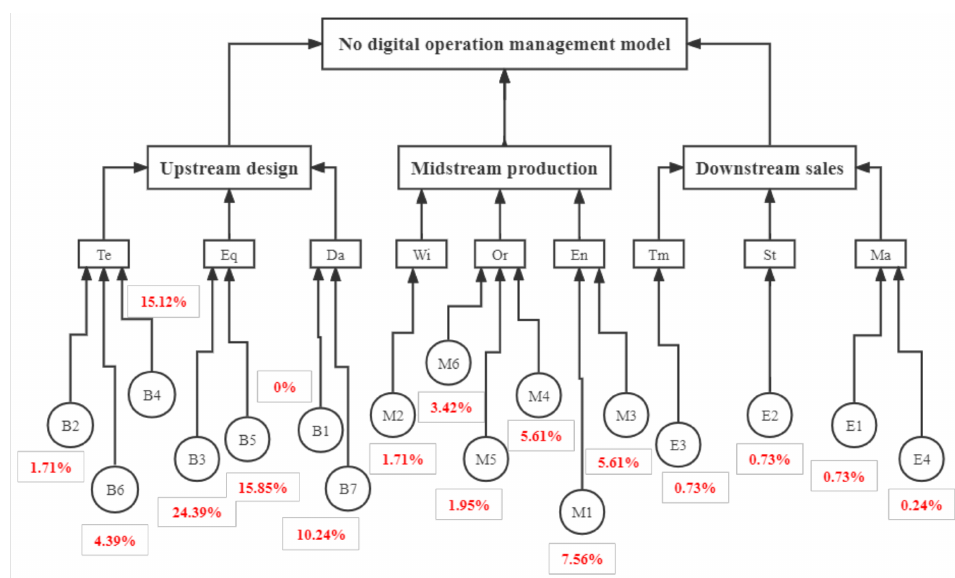
Figure 9. The fault tree diagram. Note: The figure was drawn with failure probability.